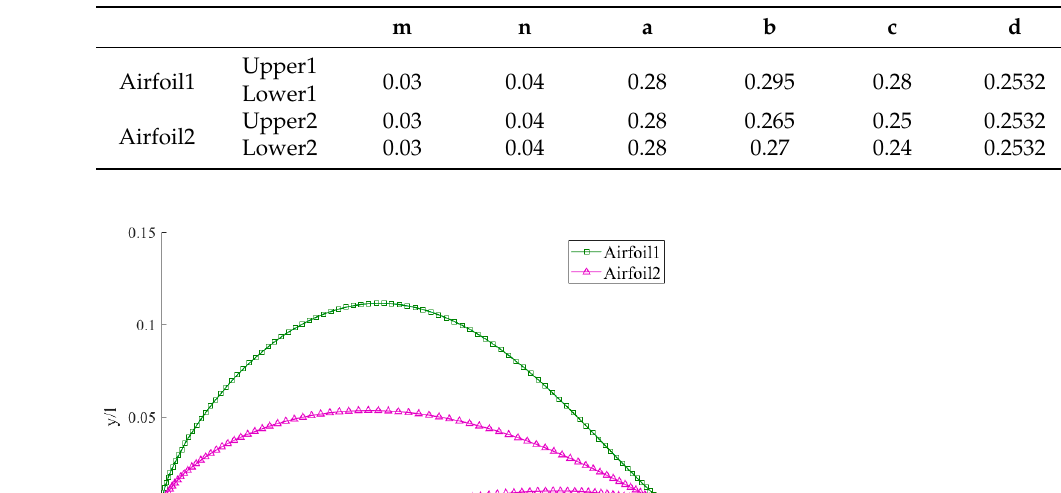
Figure 12. Geometry shape of the new airfoil. Table 2. Parameter values for generating new airfoil.